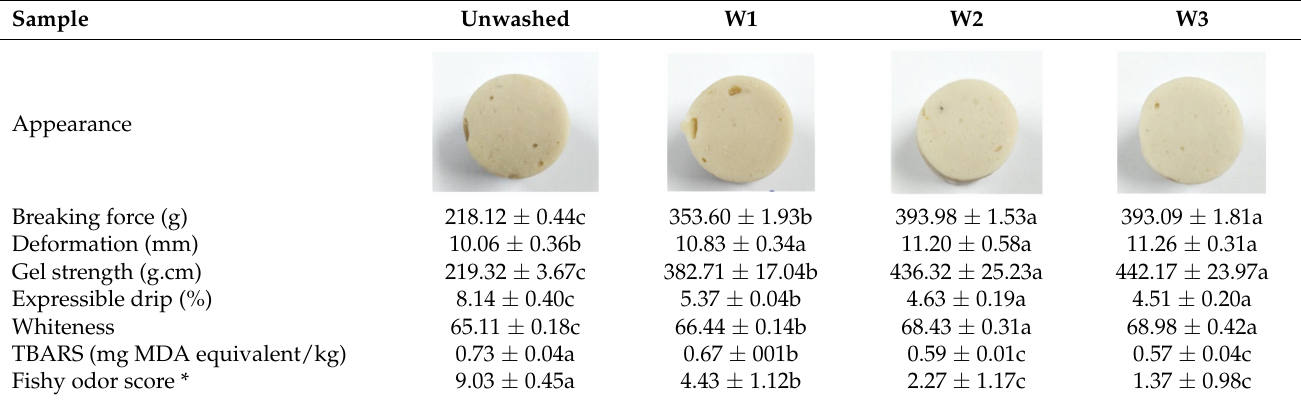
Table 2. Gelling properties of Indian mackerel unwashed mince and surimi prepared by different washing cycles.